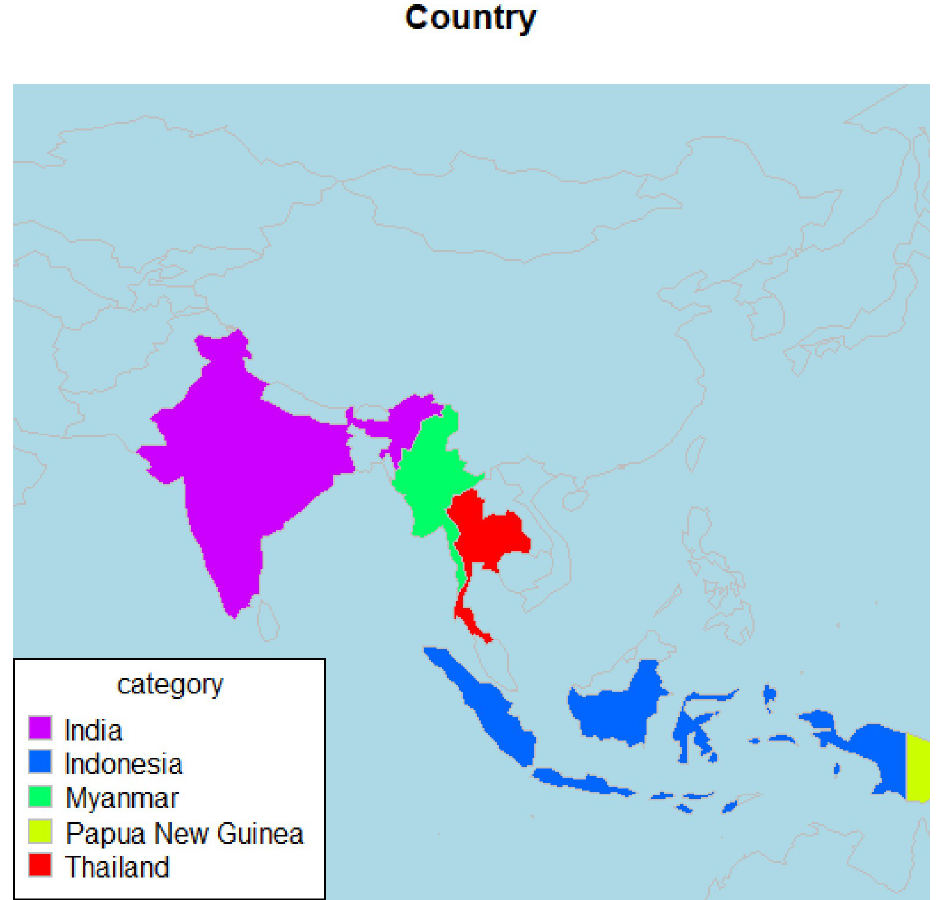
Fig 2. Geographic distribution of studies included in the